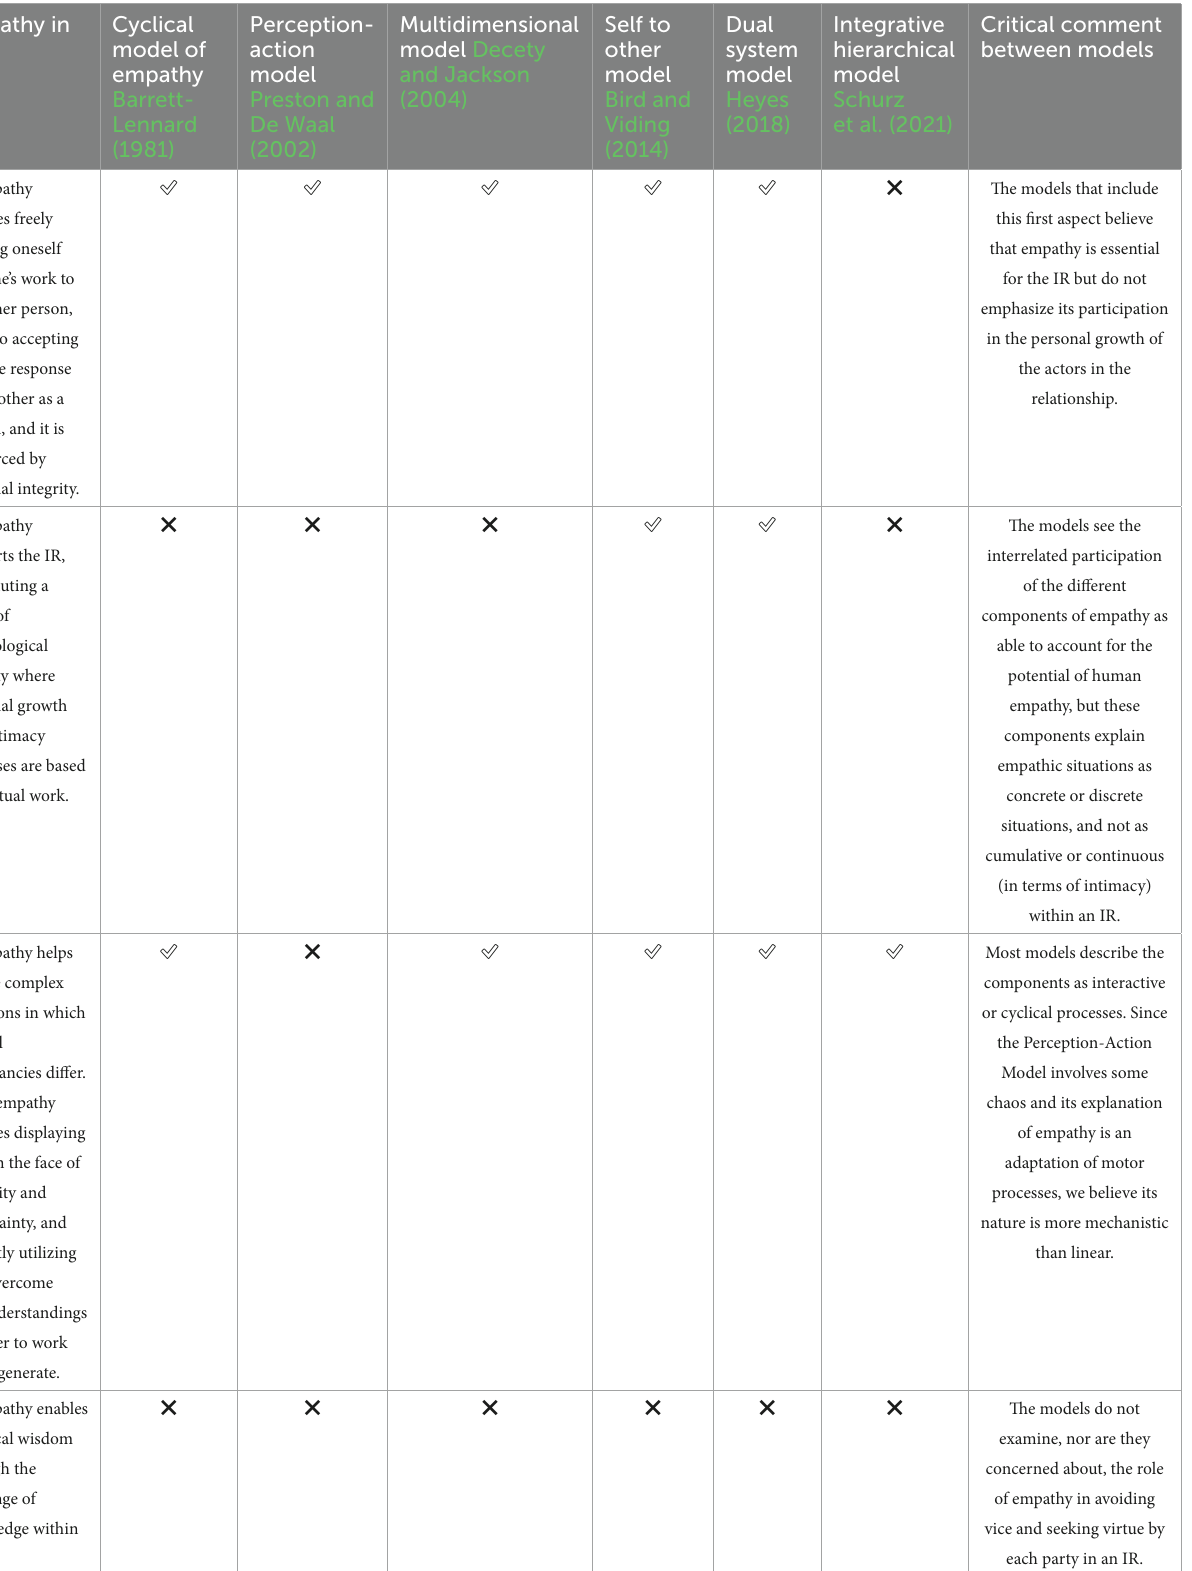
TABLE 1 Explanatory models of empathy from the perspective of